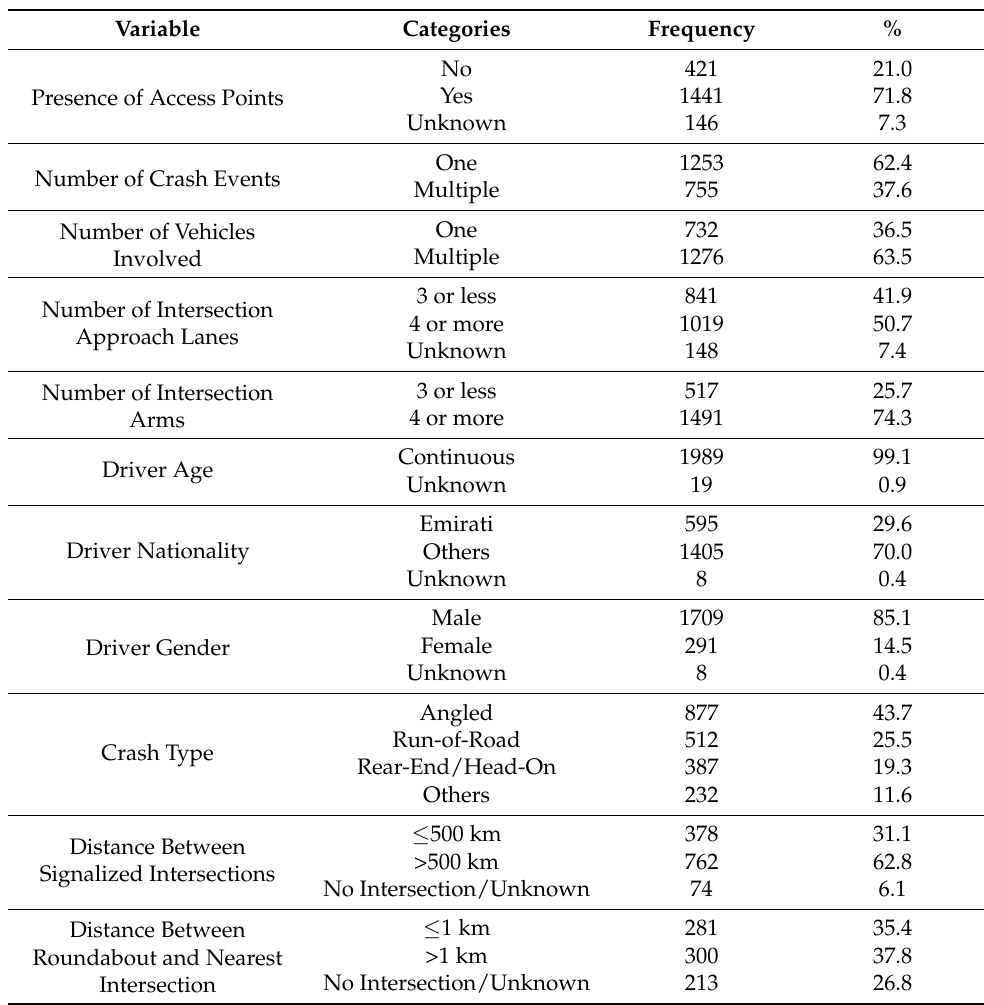
Figure 1. Crash Descriptions and Diagrams. Table 3. Intersection Crash Data Summary.